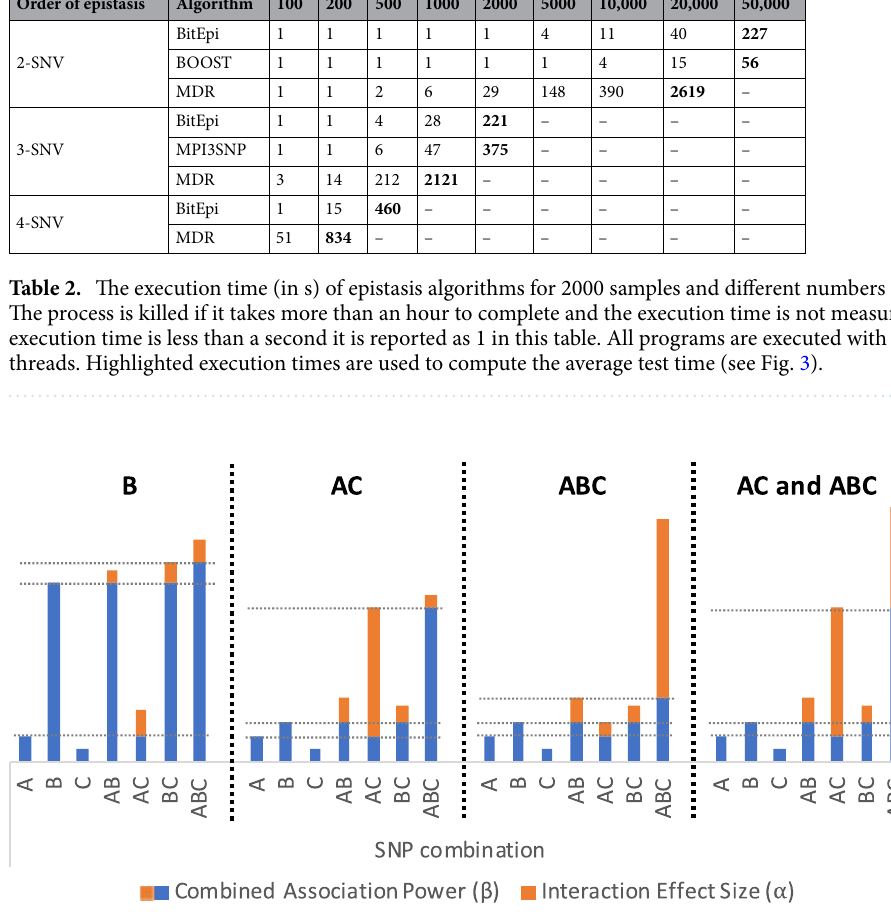
Figure 2. Four examples illustrating the effects of SNVs A, B and C. Bar height (blue and orange together) represent the maximum association power ( β ), while orange visualizes the interactional component ( α ) of the total association. From left to right: (B) SNV B strongly associated with the phenotype and none of the 2-SNV and 3-SNV combinations add considerably to the association power of SNV B. In this case, there is no interaction. (AC) Neither of SNVs shows strong association power but the combination of AC increases the association power of SNV A significantly. Adding B to the pair of AC has a minor effect on the association power. In this case, A and C strongly interact with each other. (ABC) Neither of SNVs shows strong association power. Also, 2-SNV combinations do not increase the association power of SNVs considerably. However, a combination of ABC leads to a significant increase in the association power. In this case, there is a strong 3-SNV interaction of ABC. (AC and ABC) Neither of SNVs shows strong association power but the combination of AC increases the association power of SNV A significantly. Adding B to the pair of AC further increases the association power of AC. In this case, there is a strong 2-SNV interaction of AC and a strong 3-SNV interaction of